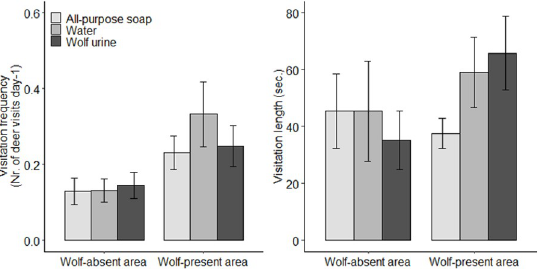
Fig 2. Visitation frequency and visitation length (mean ± SE) on the treatment plots for both study sites. Wolf- absent case study: treatment has no significant effect on visitation frequency ( H (2) = 0.096, P = 0.953) nor visitation length ( H (2) = 0.840, P = 0.657). Wolf-present case study: treatment has no significant effect on visitation frequency ( H (2) = 0.153, P = 0.926) nor visitation length ( H (2) = 2.390, P = 0.303).